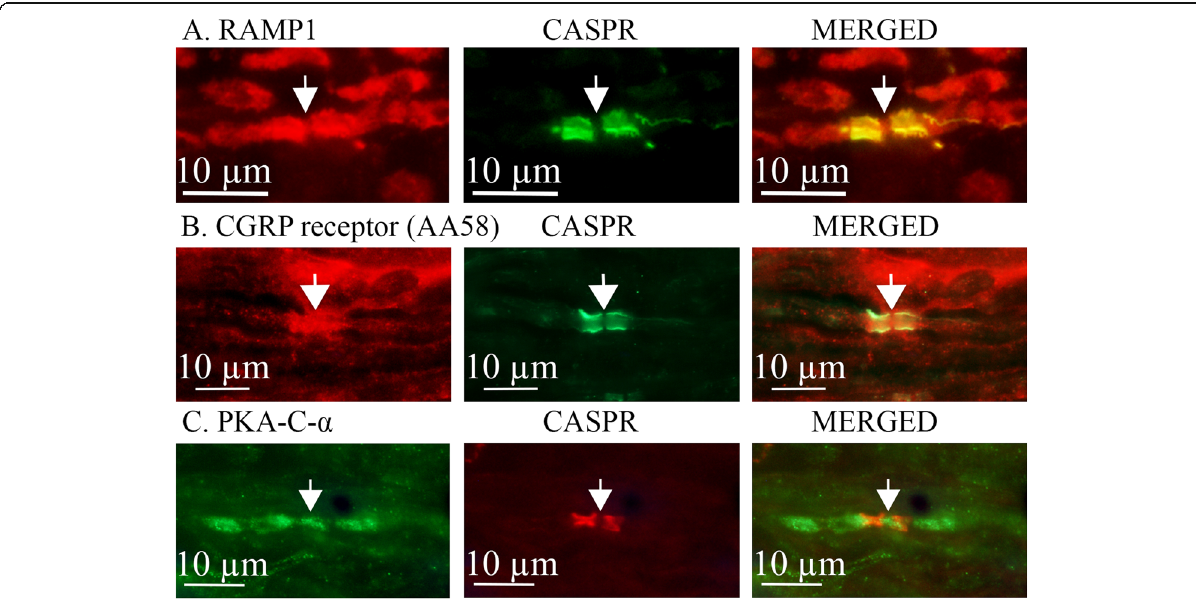
Fig. 3 Localization of CGRP receptor and PKA at the nodes of Ranvier in trigeminal axons. CGRP receptors were labeled using a RAMP1 antibody ( a ) or the AA58 antibody targeted to the functional CGRP receptor complex ( b ). Both antibodies showed co-localization with CASPR. Evidence of relevant signaling pathways is indicated by positive staining for the catalytic subunit of Protein Kinase A (PKA) at the nodes ( c ). Arrows indicate the node of